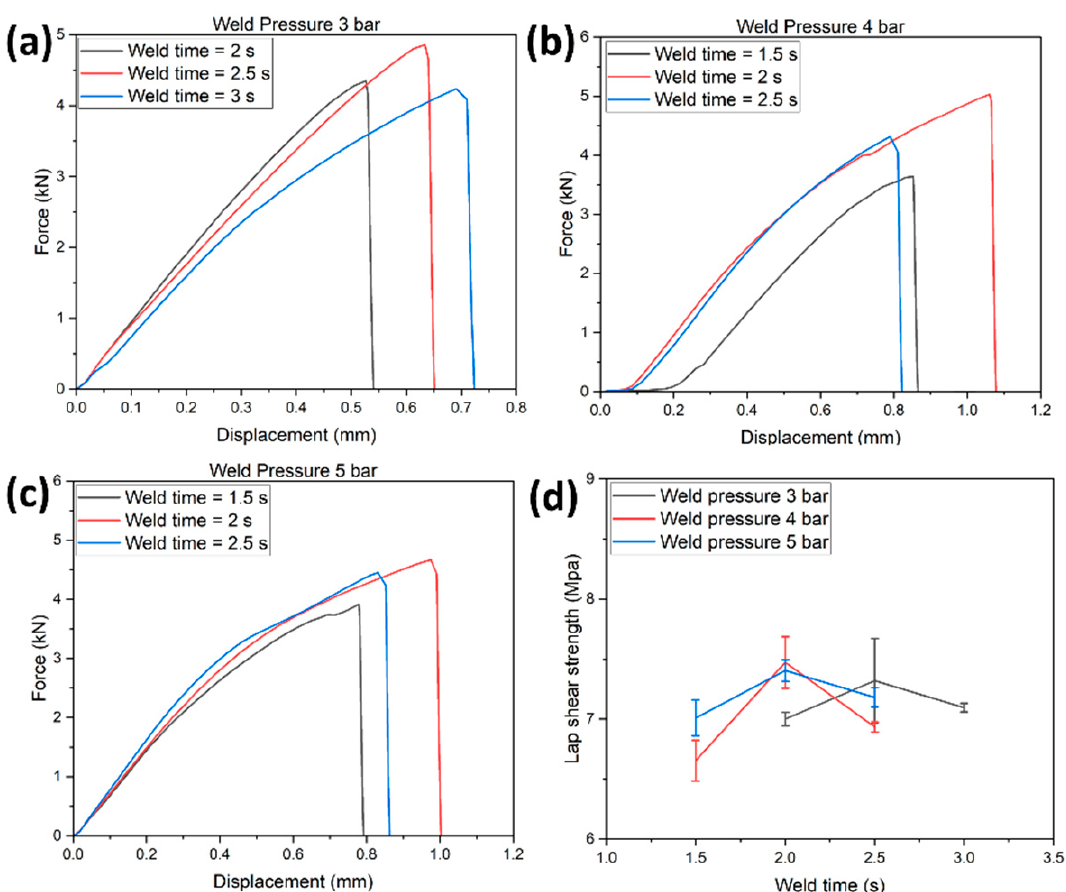
Figure 13. Load-displacement curve for EL-EP(Elium ® -Epoxy)_0.5: ( a ) Weld pressure = 3 bar, ( b ) Weld pressure = 4 bar, ( c ) Weld pressure = 5 bar. ( d ) Lap shear strength vs. weld time.